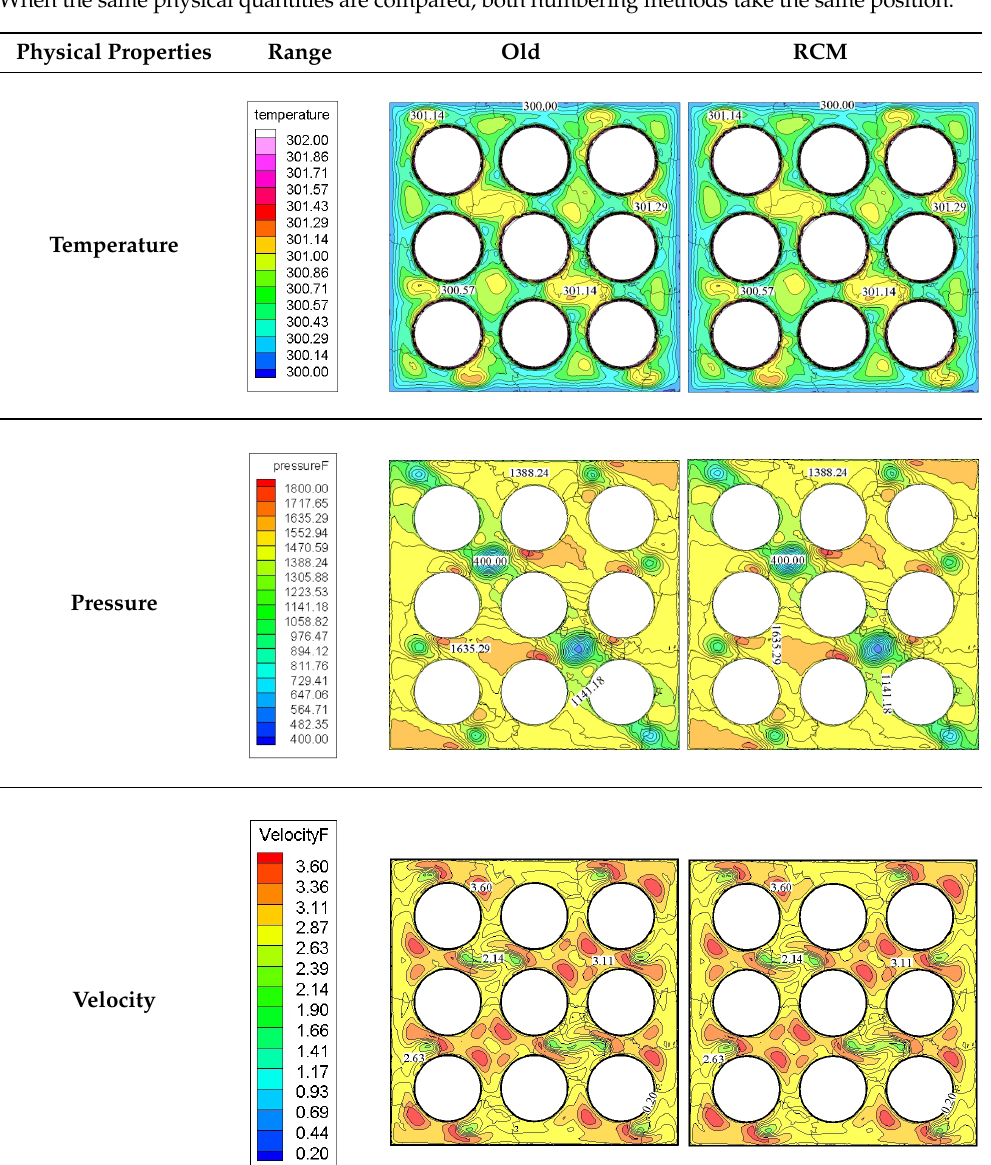
Table 3. Contour clouds for slices with Z = − 0.01. The first column indicates the different physical quantities. The second column indicates the range of physical quantities in the cloud map. The third and fourth columns show the sliced clouds at the same locations before and after the renumbering algorithm. The white numbers in each cloud represent the values of physical quantities at the current position. When the same physical quantities are compared, both numbering methods take the same